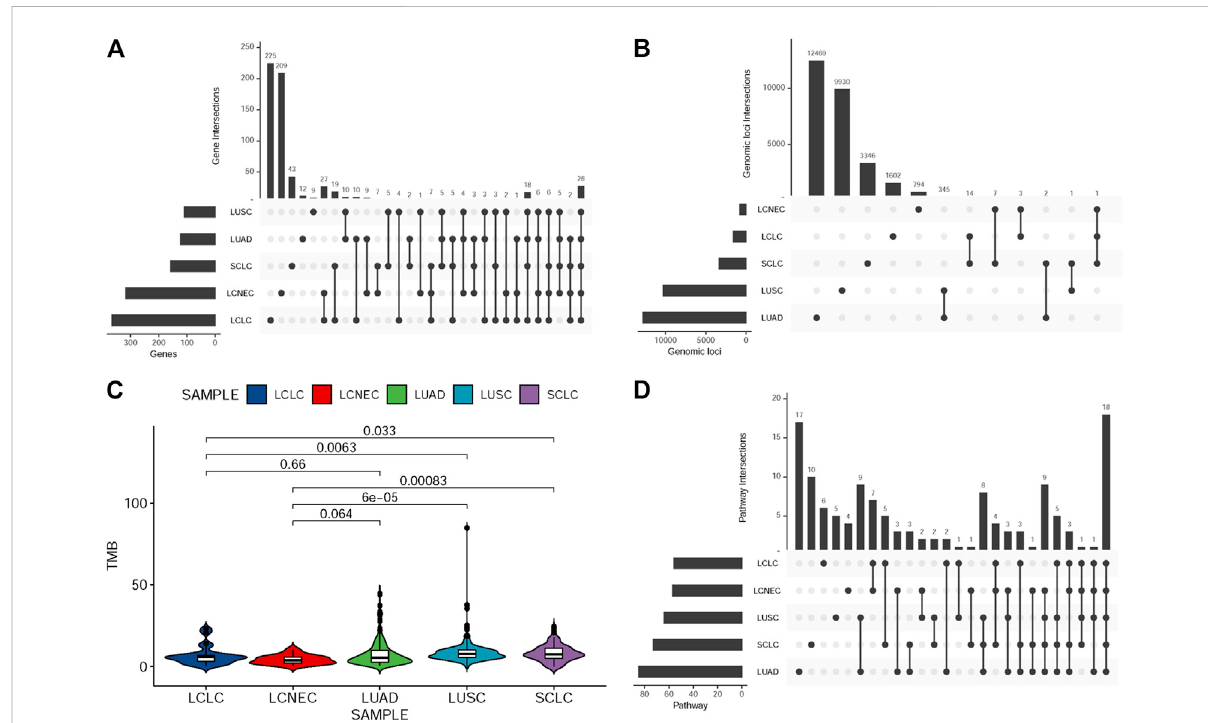
FIGURE 5 Comparison of mutation landscape between this cohort and other three subtypes. (A) UpSetR plot shows the overlap of germline-regulated genesidenti fi edinthepresentstudyforthe fi velungcancersubtypes. (B) UpSetRplotshowstheoverlapofindependentgenomiclocithatrepresent the genes shown in (A) . (C) The TMB difference in the fi ve lung cancer subtypes. (D) UpSetR plot shows the overlap of pathways from the Kyoto Encyclopedia of Genes and Genomes enriched with the germline-regulated